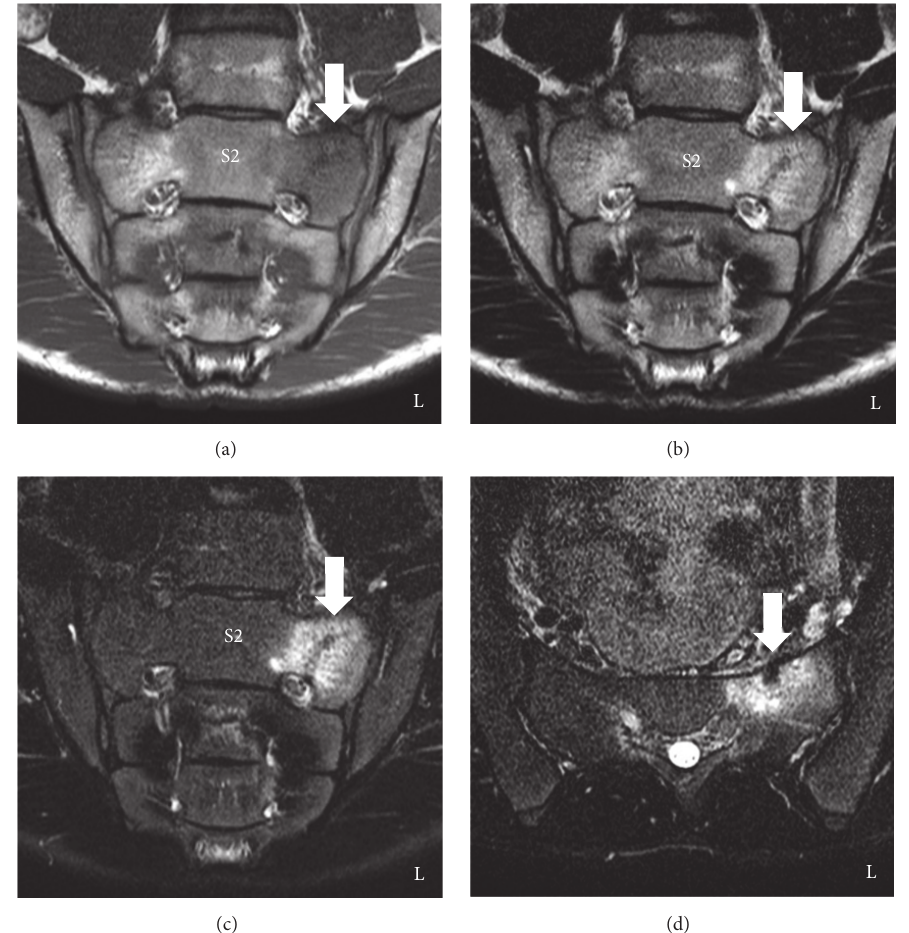
Figure 3: Magnetic resonance image of the sacrum at the first visit to our hospital. (a) Coronal plane on a T1-weighted image. (b) Coronal plane on a T2-weighted image. (c) Coronal plane on a short TI inversion recovery (STIR) image. (d) Axial plane at the S2 level on a STIR image. The left sacral ala on a T1-weighted image shows a low intensity (a), a T2-weighted image shows a high intensity (b), and on a STIR image shows a high intensity (c) compared with the right sacral ala. These radiological findings indicated bone marrow edema. Oblique lineal signal void (white arrows) can be seen in the bone marrow edema; these are fracture lines. An axial plane on a STIR image shows a low-intensity area (white arrow) surrounded by a high-intensity area in the left ventral surface of the sacral ala (d).